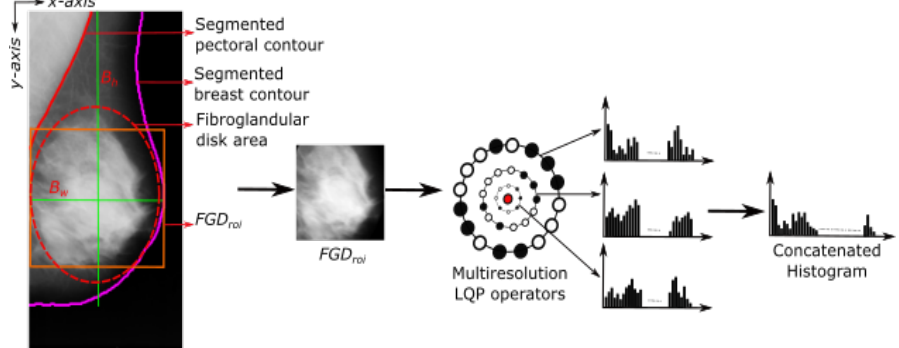
Figure 5. An overview of the feature extraction using multiresolution LQP operators. Black dots in multiresolution LQP operators mean neighbours with less value than the central pixel (red dot). Note that the outer circle with bigger dots represent a larger R value.